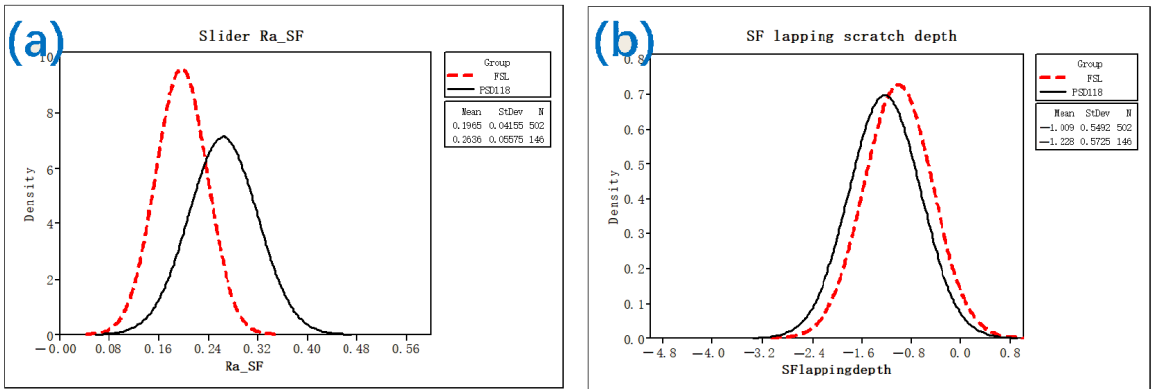
Figure 17. Comparison of Ra and the scratch depth under different conditions: ( a ) surface roughness (Ra); ( b ) scratch depth.